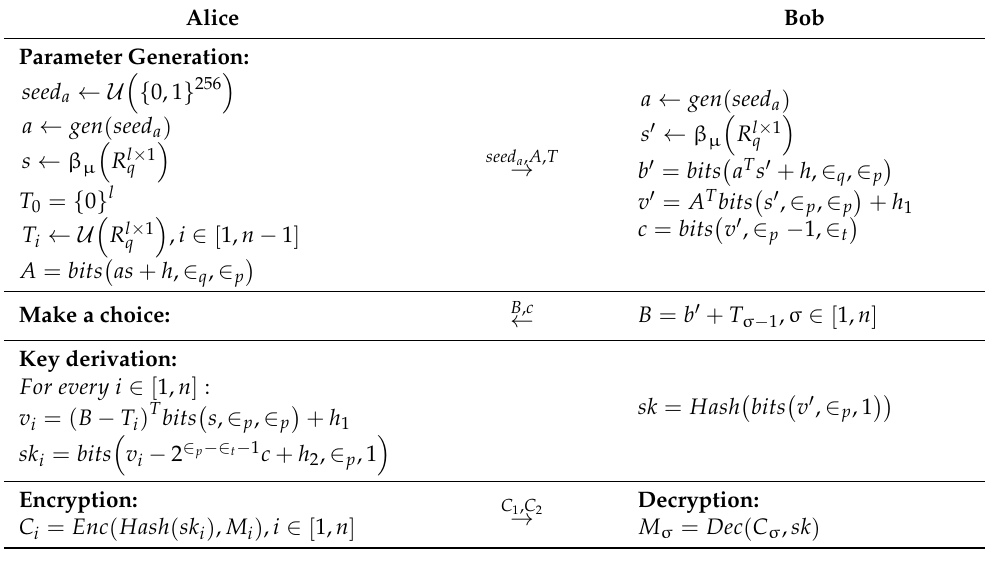
Table 5. UC-secure 1-out-of-N OT protocol. Alice